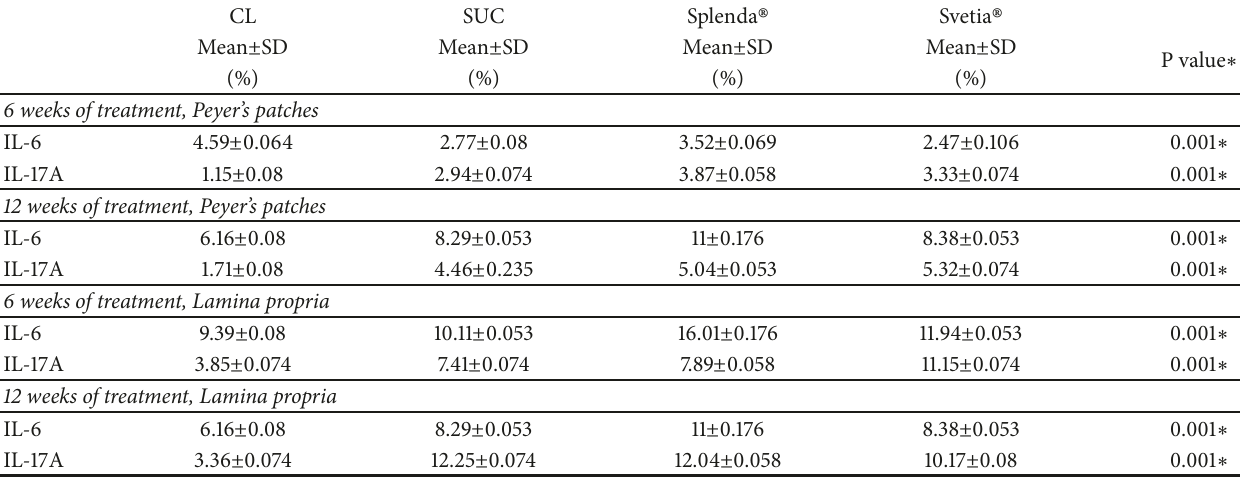
Table 4: Cytokine CD4 + T cell response from Peyer's patches and lamina propria of CD1 mice supplemented with sweeteners for 6 and 12